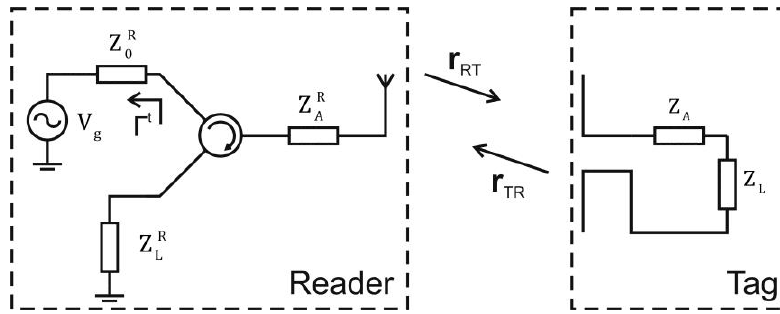
Fig. 1. The b ackscatter